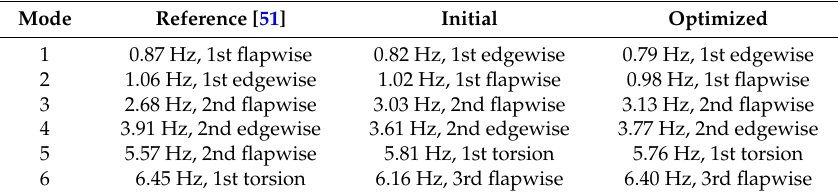
Table 3. Modal frequencies of the initial and optimized blades.